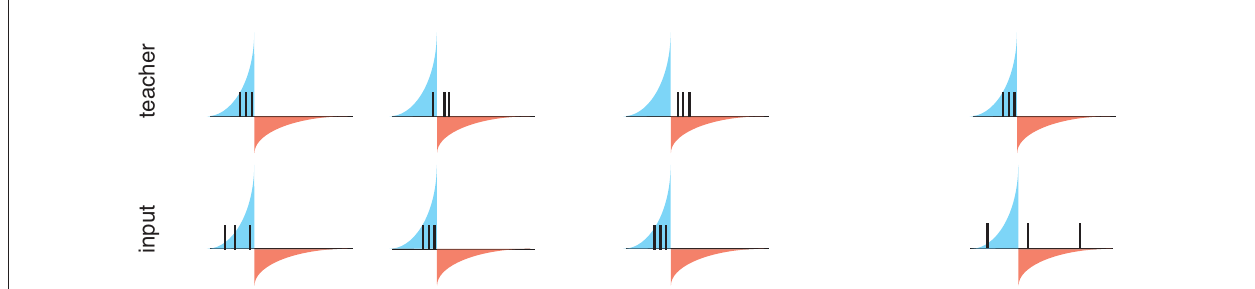
nascent input ( top ), but also results in some teacher spikes in the LTD window ( bottom ), resulting in eventual weakening of the teacher. Right : With the nascent input “learned”, teacher spikes fall completely in the weakening window ( bottom ), reinforcing a weak teacher input and strong learned input. ( B) During deprivation, the learned input can no longer drive postsynaptic firing, and learned input becomes uncorrelated with postsynaptic spikes ( bottom ), and the teacher begins to drive student firing again and